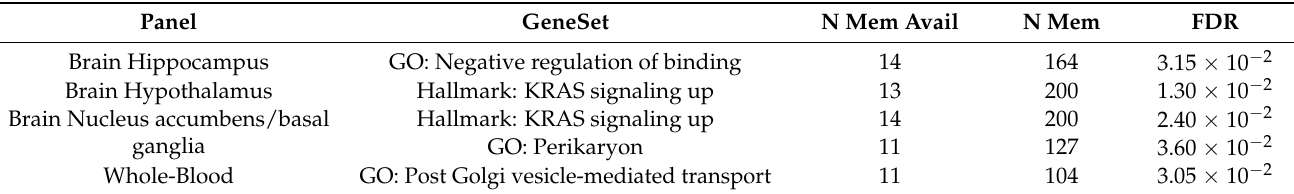
Table 3. Biological processes significantly enriched with TWAS signals of ALS (FDR < 0.05). N mem avail denotes the number of TWAS signals involved in the reference gene set used in this analysis; N mem denotes the total number of genes in the reference gene